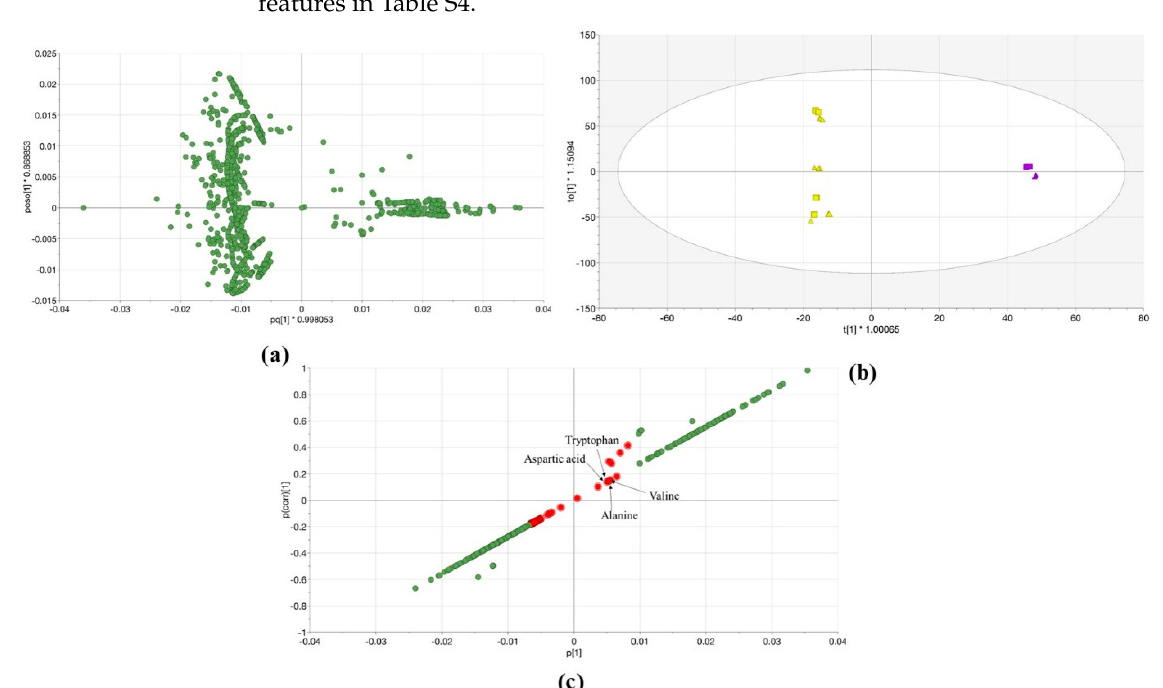
Figure 4. ( a ) The loading plot displays the relation between the different Lemna minor samples 100% MeOH and 100% H 2 O extracts analyzed with single TOF-MS (system A) and QTOF-MS/MS (system B); ( b ) OPLS-DA score scatter plot of Lemna minor samples 100% MeOH (triangular) and 100% H 2 O (squares) extracts analyzed with single TOF-MS (violet) and QTOF-MS/MS (yellow). The confidence limit is 95%; ( c ) The S-plot of Lemna minor 100% MeOH and 100% H 2 O extracts with red marked molecules that represent the common ones between the two machines. Tryptophan, aspartic acid, alanine, and valine were prioritized by the PLANT-IDENT database and identified using reference standards as shown in Sections 2.4 and 2.5.